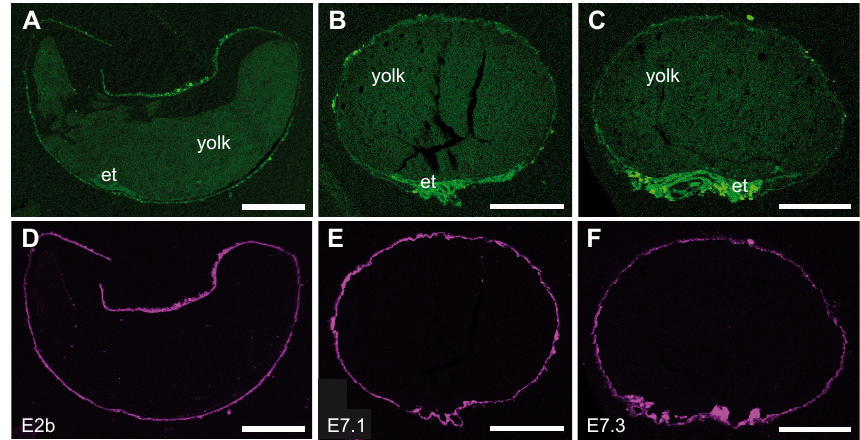
Fig. 4. Post-experimental distribution of P and Ca of sliced crayfish eggs. X-ray mappings of (A) – (C) P and (D) – (F) Ca highlight both the degree of morphology preservation and of continuous brushite and calcite mineralization (scale bar: 400µm; E2b, E7.1, etc.=experiment number; et=embryonic tissue of the germ area).